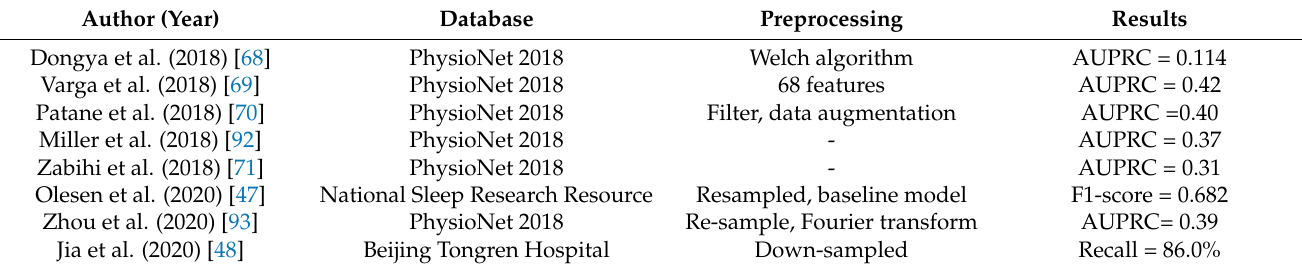
Table 5. Detailed information of models using the